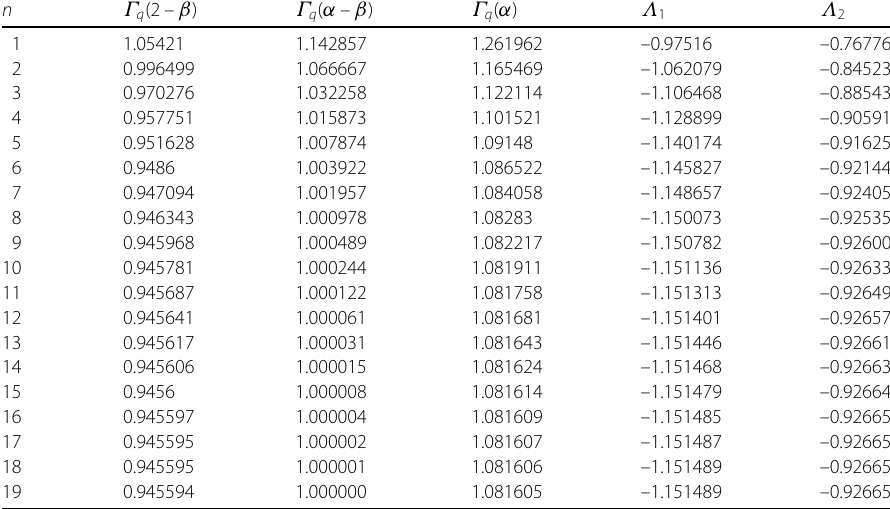
Table 5 Some numerical results for calculation of Λ 1 and Λ 2 with q = 1 Example